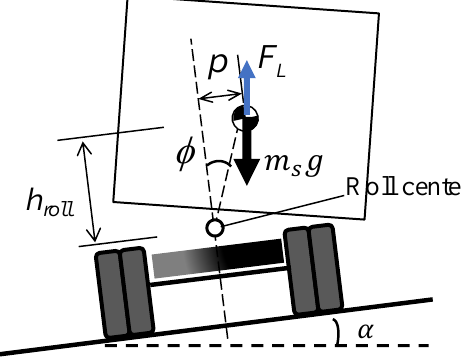
Figure 9. Additional rolling moment induced by lateral displacement of sprung mass.